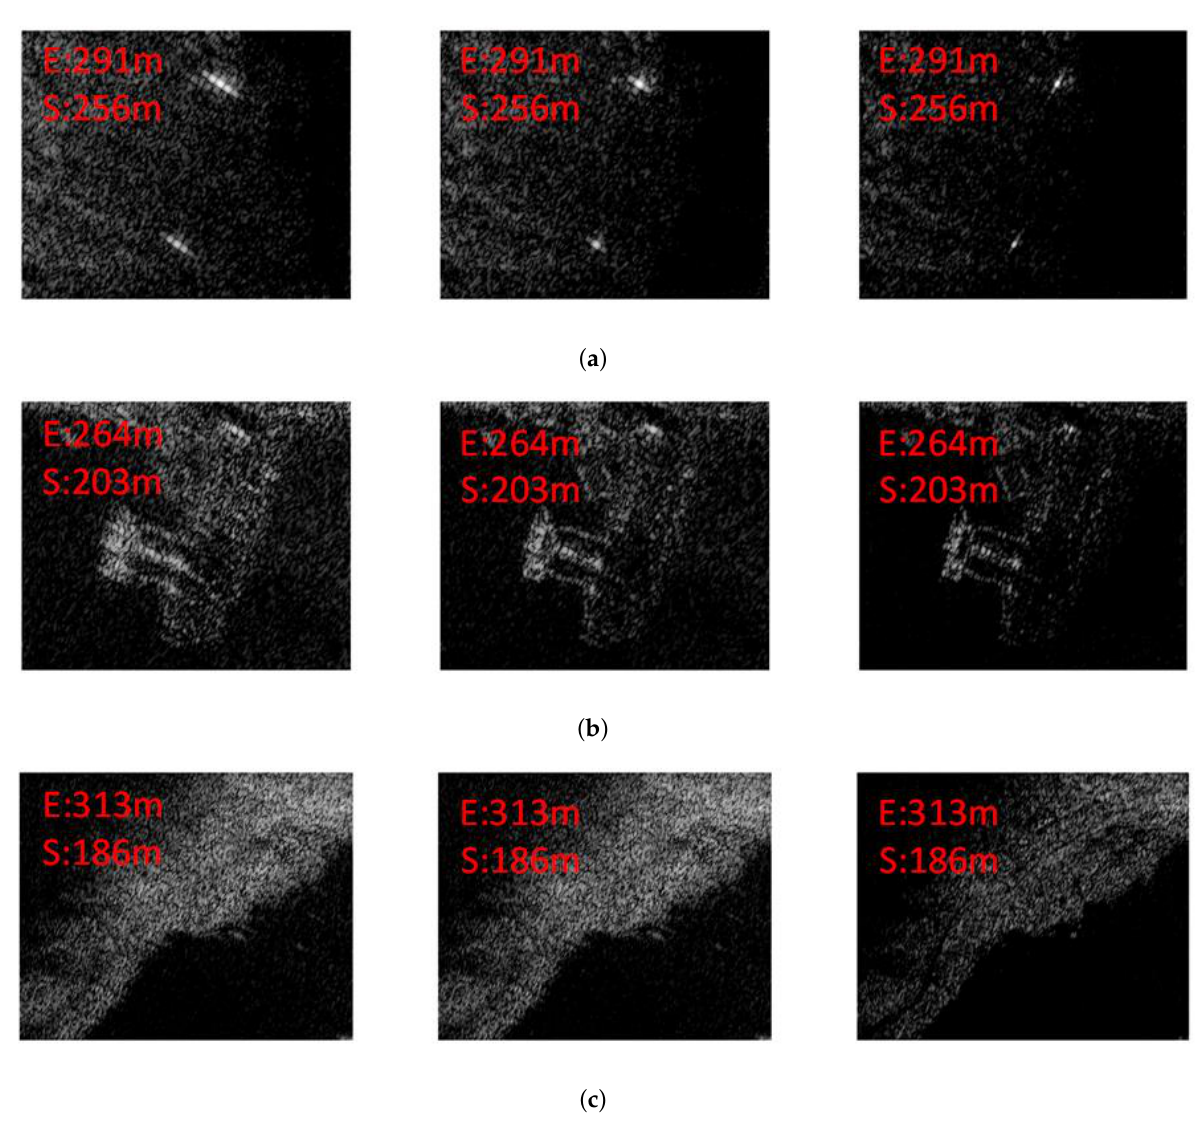
Figure 16. Enlarged image results of different MOCO algorithms. ( a ) is the image result of two transponders. ( b ) is the image result of the wharf. ( c ) is the image result of a road. From left to right are the image results without MOCO, with traditional MOCO algorithm [11,23], and with proposed MOCO